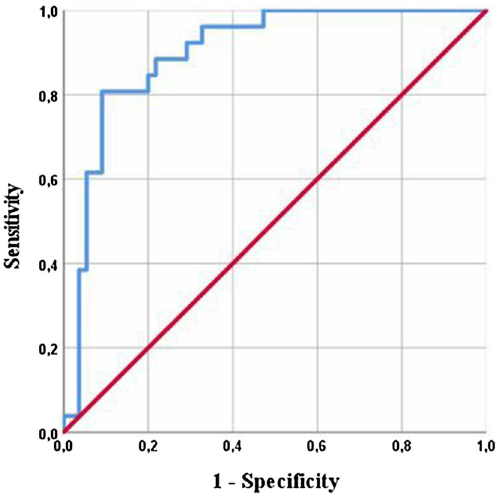
Figure 3. Receiver operating characteristics (ROC) curve of the serum levels of calprotectin for diagnosing a prosthetic joint infection using a cut-off value of 9910